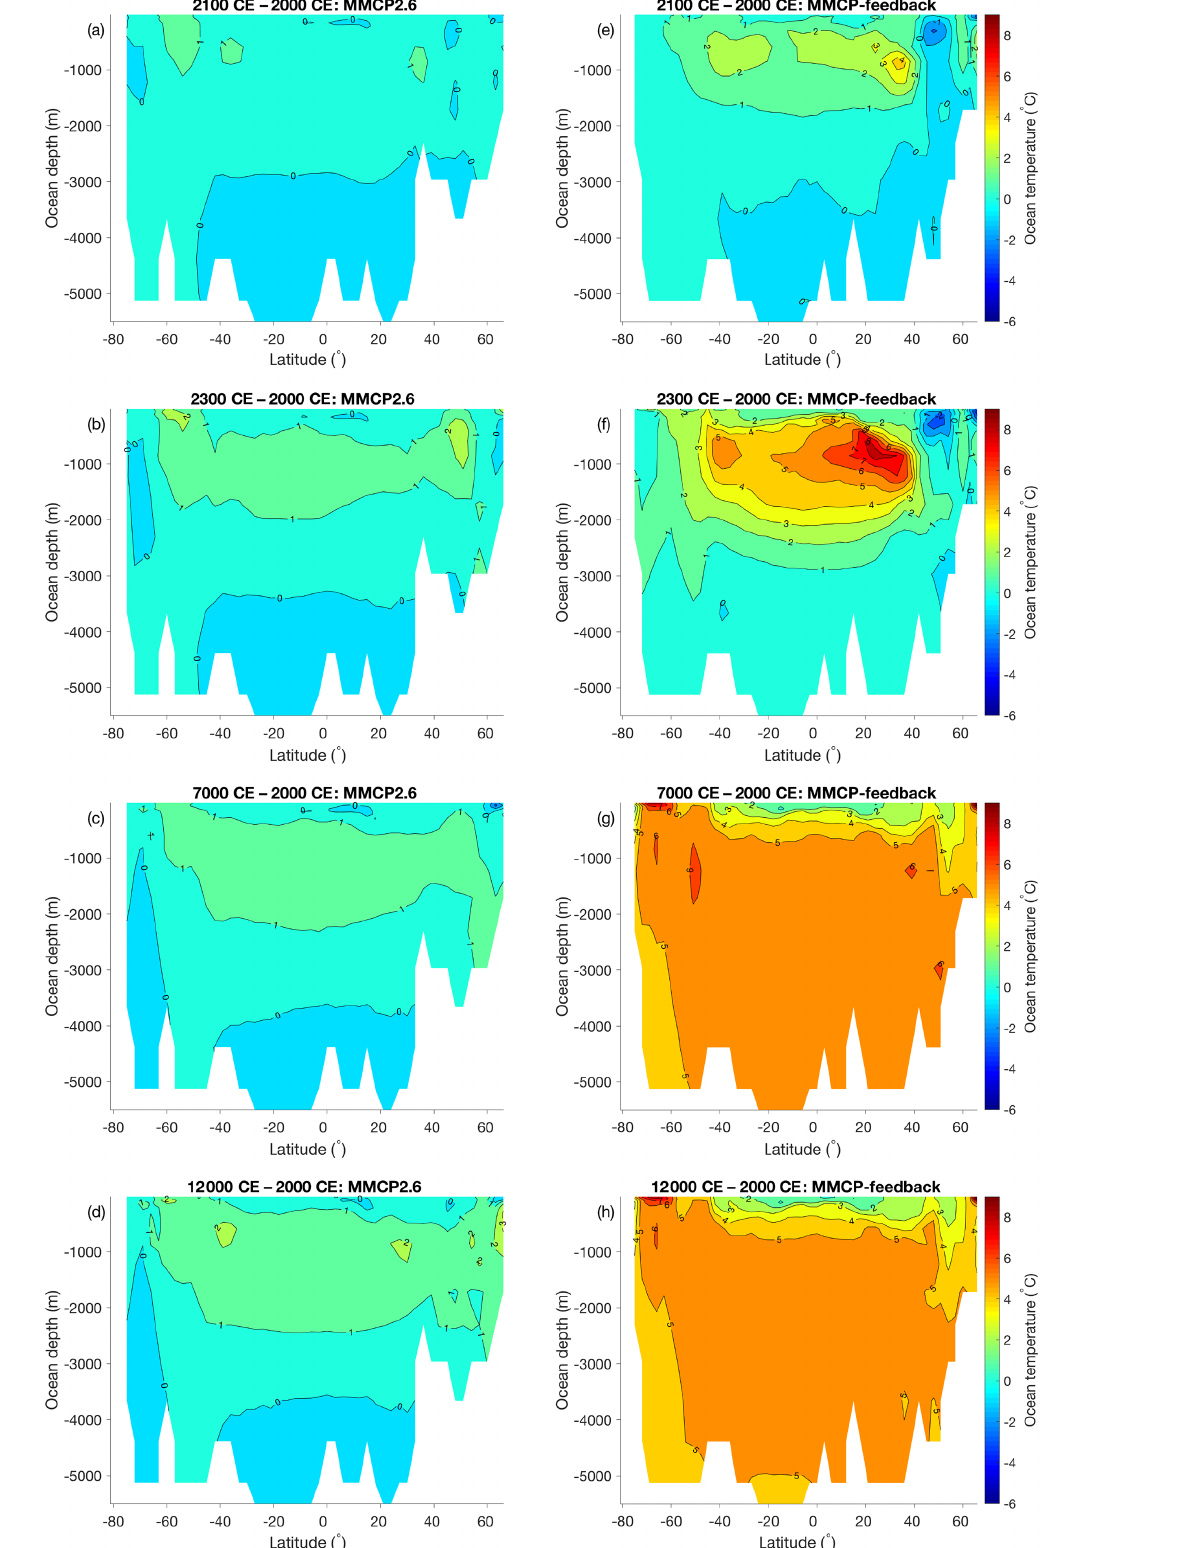
Figure 6. Ocean temperature anomaly across the Atlantic ocean using scenario MMCP2.6 at 2100CE (a) , 2300CE (b) , 7000CE, and (c) , 12000CE (d) and using scenario MMCP-feedback at 2100CE (e) , 2300CE (f) , 7000CE (g) , and 12000CE (h) .